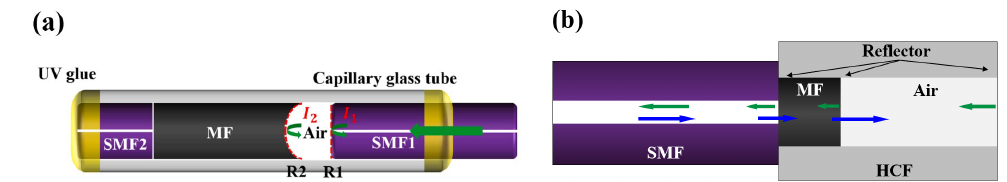
Figure 4. Magnetic field fiber sensors based on ( a ) one-FPI (reprinted with permission from Ref. [40], 2022, Elsevier) and ( b ) treble-FPI [42].